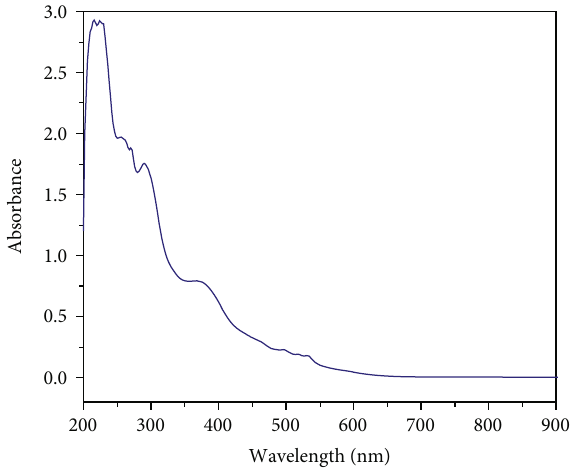
Figure 11: Optical absorption spectra of root of Knipho fi a schemperi sensitizer.